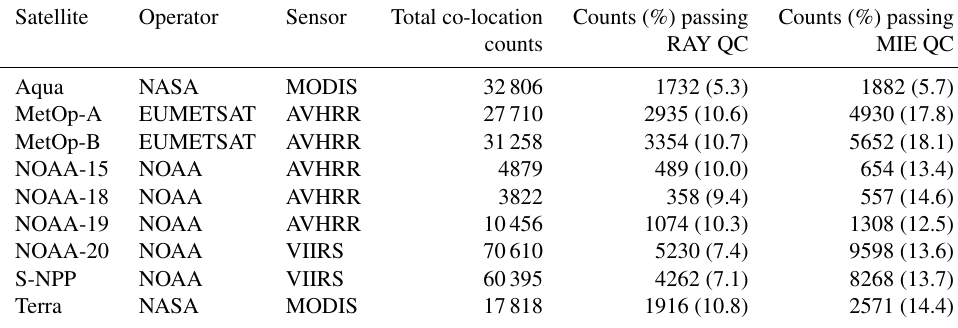
Table 2. As in Table 1 but for all LEO IR window channel AMVs.